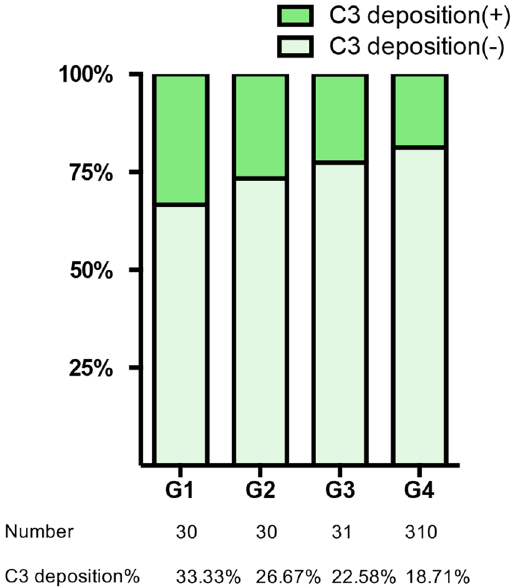
Figure 1. The correlation between the C3 deposition in the kidney and serum C3 levels. G1: the first third of the low serum C3 group; G2: the second third of the low serum C3 group; G3: the last third of the low serum C3 group; G4: the normal serum C3 group. The p value for trend was 0.038( χ 2 = 4.32).